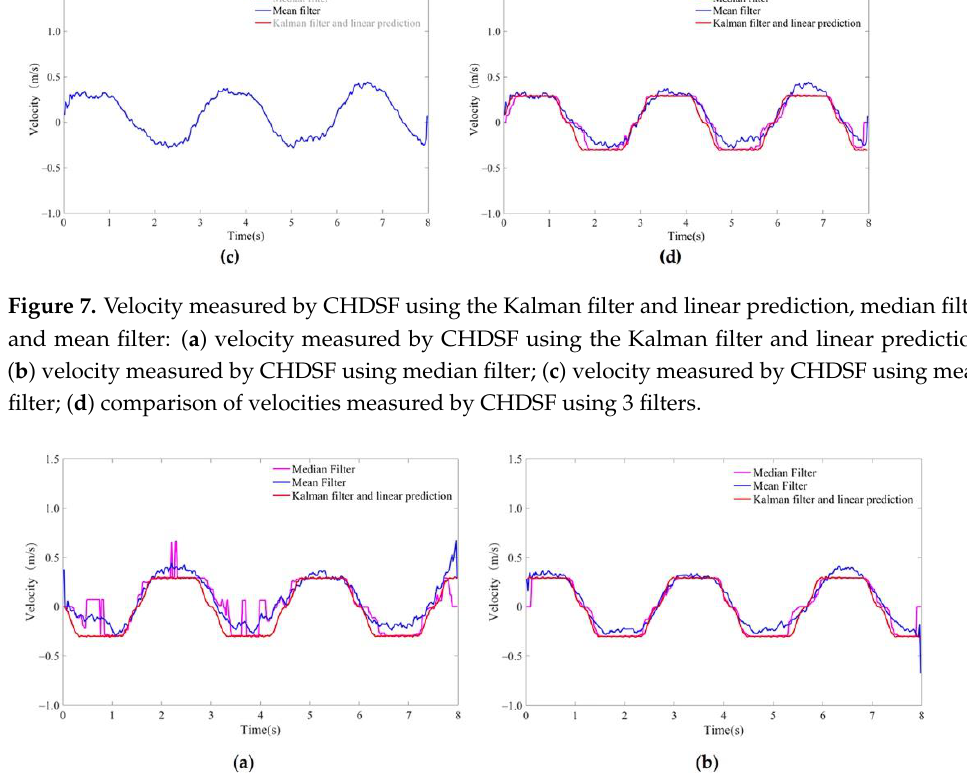
Figure 7. Velocity measured by CHDSF using the Kalman filter and linear prediction, median fil- ter and mean filter: ( a ) velocity measured by CHDSF using the Kalman filter and linear prediction; ( b ) velocity measured by CHDSF using median filter; ( c ) velocity measured by CHDSF using mean filter; ( d ) comparison of velocities measured by CHDSF using 3 filters.